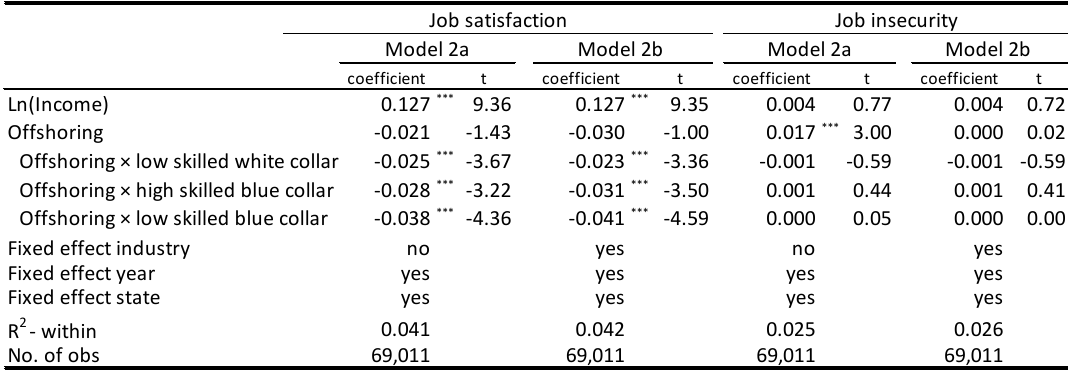
Table 4 . Job satisfaction, job insecurity and offshoring – Excluding NACE 1–14 industries